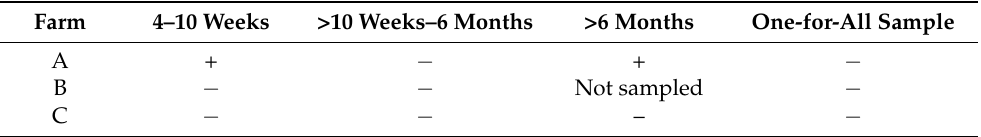
Table 3. Summary of the RT-qPCR results from sock swabs from three farms that had a one-for-all as well as individual sock swabs sampled from the different age